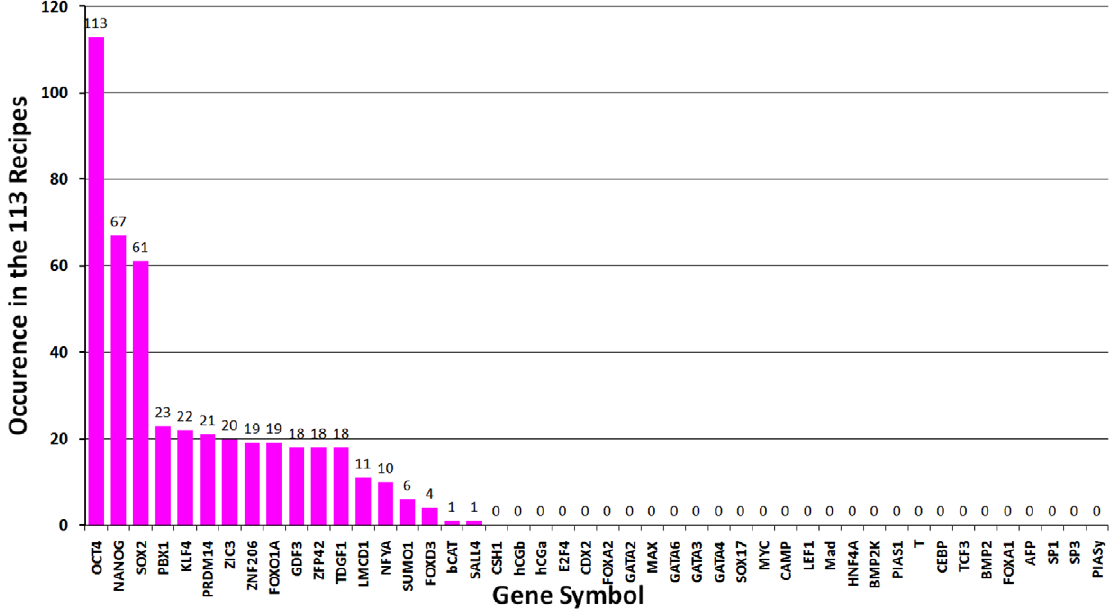
Figure 3. Occurrence of proteins in the 113 4-factor candidate reprogramming recipes. doi:10.1371/journal.pcbi.1002300.g003 PLoS Computational Biology |